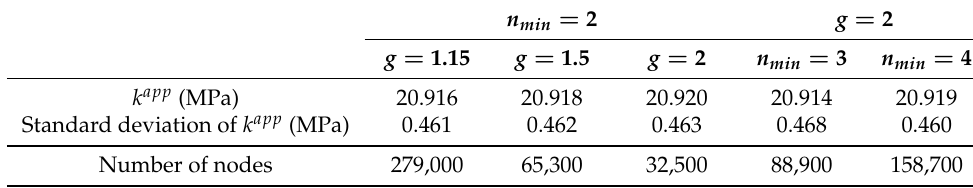
Table 1. Mesh convergence of k app , SR = 2.5, f v = 13.4 %, contrast = 100. n min = 2 g = 2 g = 1.15 g = 1.5 g = 2 n min = 3 n min = 4 k app (MPa) Standard deviation of k app